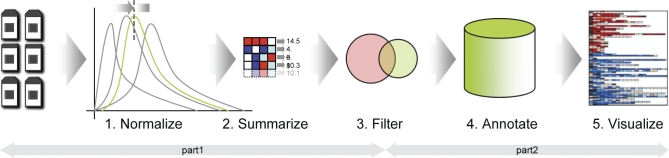
Exon Arrays Can Be Analysed Using Standard Approaches Developed for 3′IVT ArraysA standard pipeline for array processing involves 1. normalizing the arrays, 2. generating expression summaries, 3. filtering on correlation, fold-change, and/or statistical significance to select interesting probesets, 4. mapping those probesets to their target transcripts by annotation, and 5. visualization and downstream analysis.